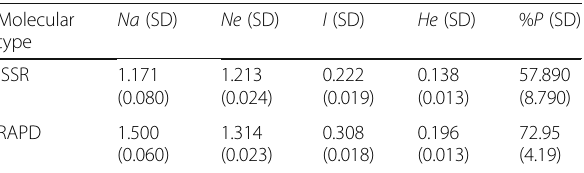
Table 3 Genetic variation statistics revealed through RAPD and ISSR markers among the B. hyrcana populations